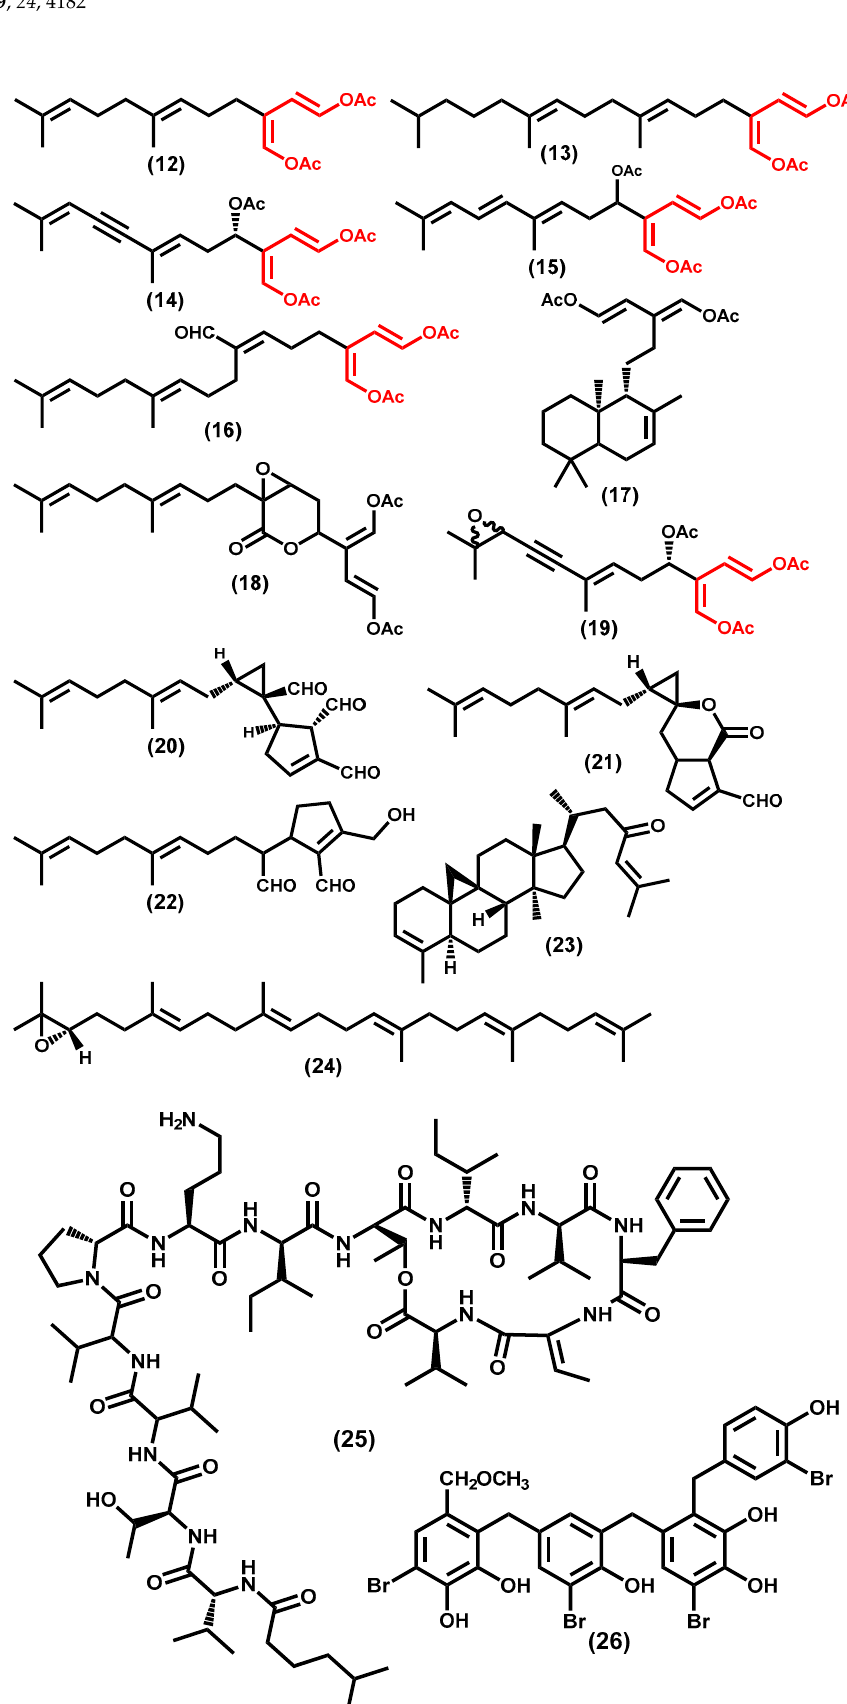
Figure 4. Chemical structure of secondary metabolites from green algae. (Ac=CH 3 CO).